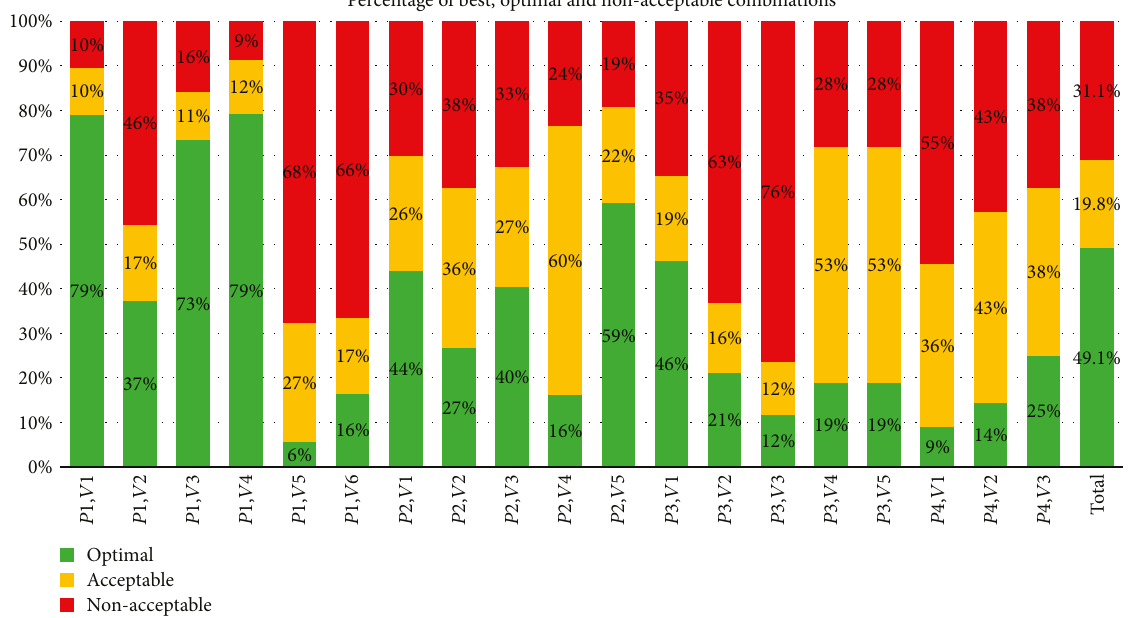
Figure 7: Percentage of optimal, acceptable, and non-acceptable pairwise combinations of parameter values.